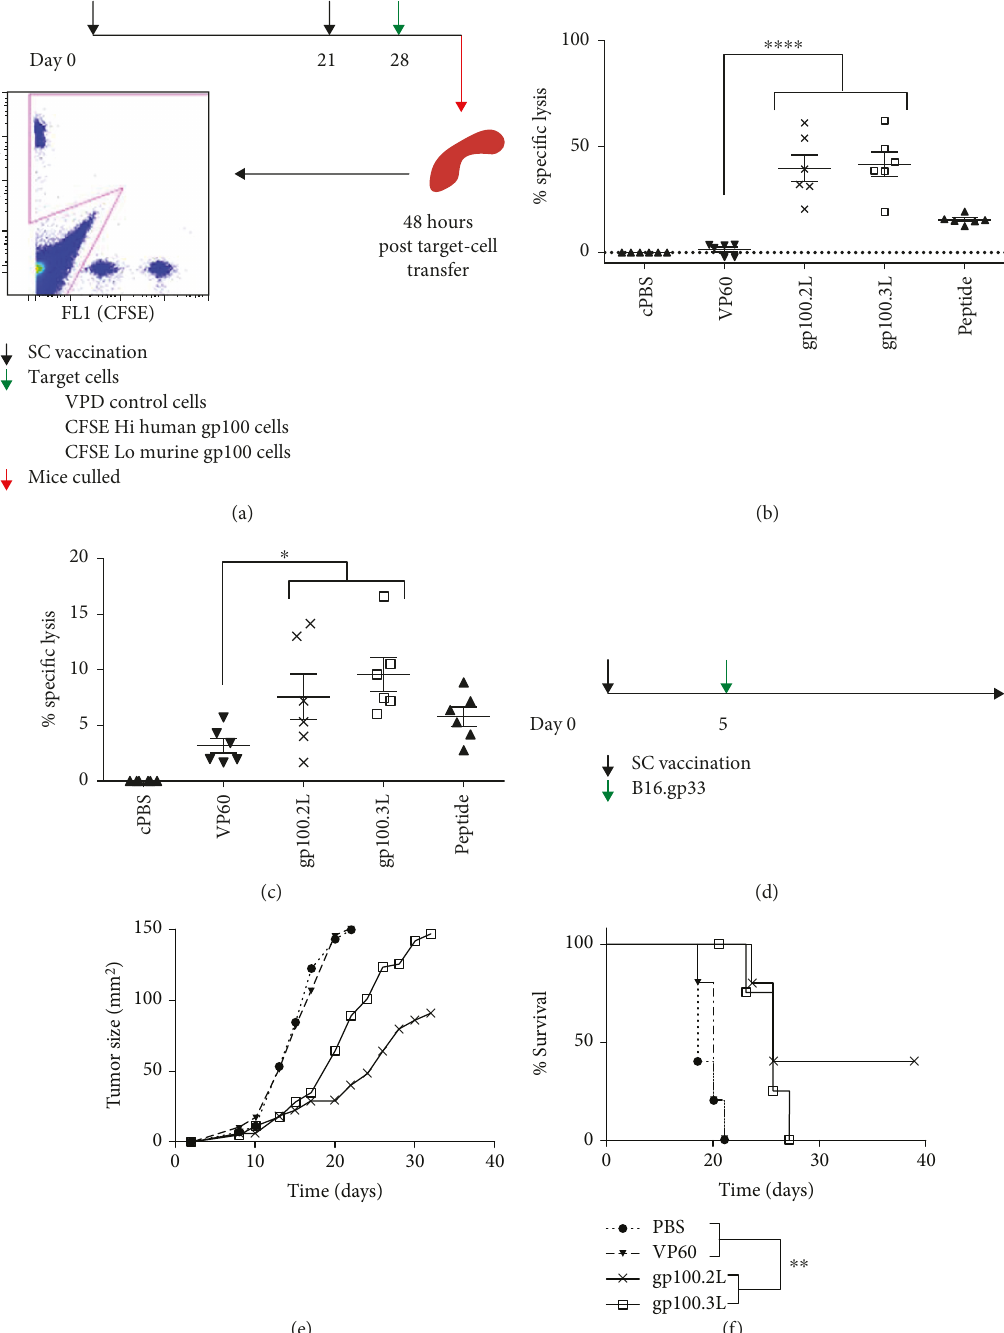
Figure 3: In vivo evaluation of gp100 VLPs. (a) Timeline of cytotoxicity assay. n = 6 mice were vaccinated on day 0 and 21 with 100 μ g VLP, cPBS negative control or gp100 peptide at a molar equivalent to gp100 within gp100.3L, each including 25 μ g CpG. On day 28, mice were injected with 1 × 10 7 fl uorescently labelled target cells, either pulsed with human gp100, murine gp100 peptide or left unpulsed. Mice were culled 48hr after target cell injection, and target cells were analysed. Percentage of speci fi c lysis of (b) human gp100 and (c) murine gp100 target cells normalised against the cPBS group. Statistical signi fi cance for cytotoxicity is the comparison between VP60- and gp100- vaccinated mice as determined by one-way ANOVA with Tukey ’ s post hoc tests, ∗∗∗ p < 0 001 , ∗ p < 0 05 . (d) Vaccination strategy: n = 5 mice were injected s.c. with 5 × 10 5 B16.gp33 tumour cells. On day 5, mice were vaccinated with 100 μ g VLP or cPBS negative control, each including 25 μ g CpG. The graphs show the (e) mean tumour growth rate or (f) survival proportions. Signi fi cance was determined using a log-rank (Mantel-Cox) test, ∗∗ p < 0 01